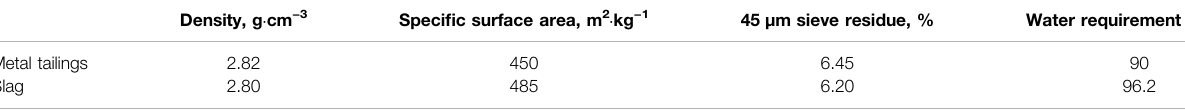
TABLE 2 | Technical indexes of metal tailings powder and slag powder.